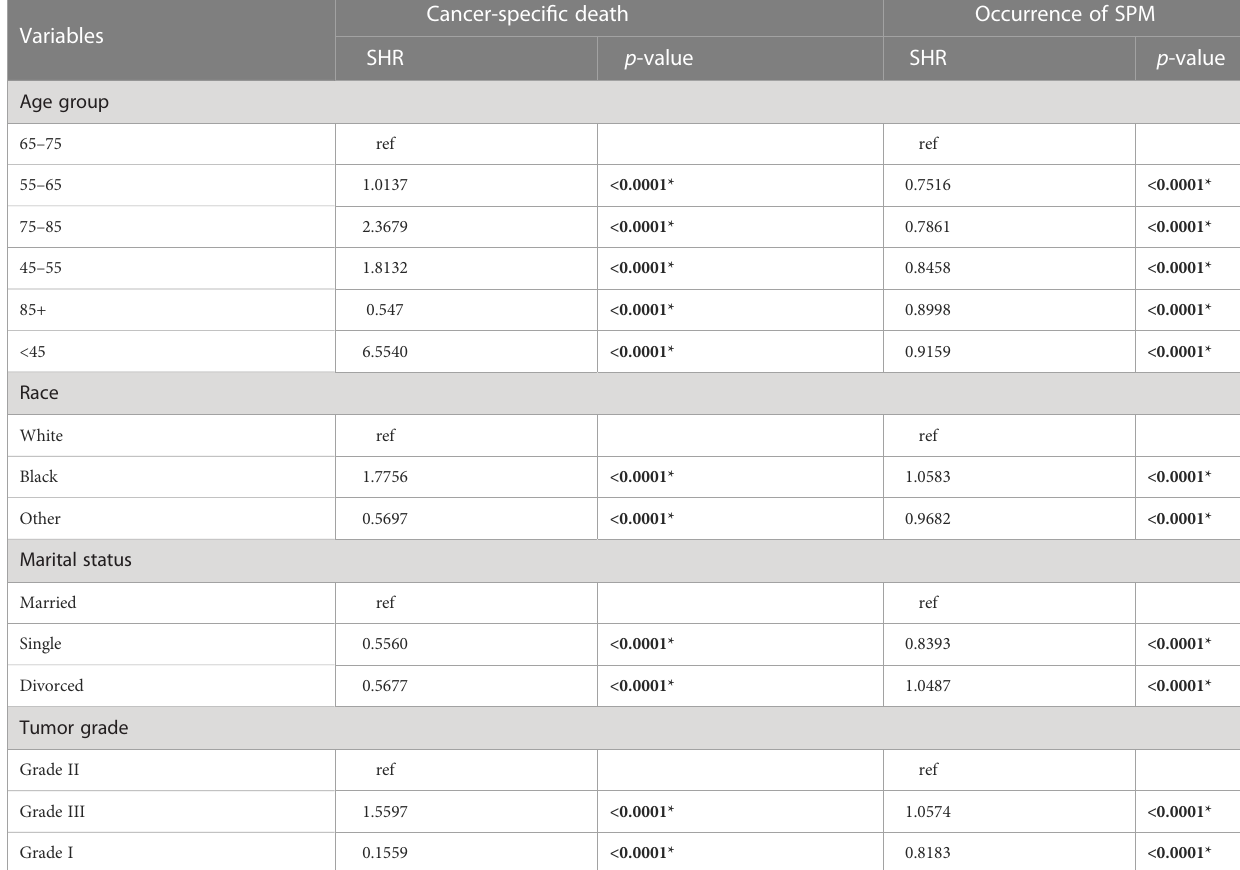
TABLE 5 Risk factors associated with cancer-speci fi c death and occurrence of